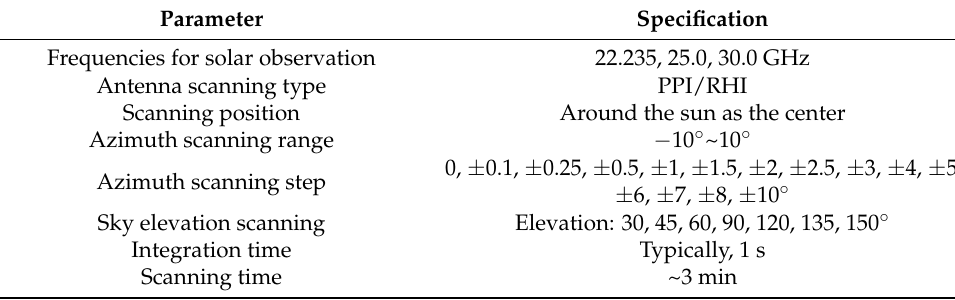
Table 2. Scan parameters used for sun